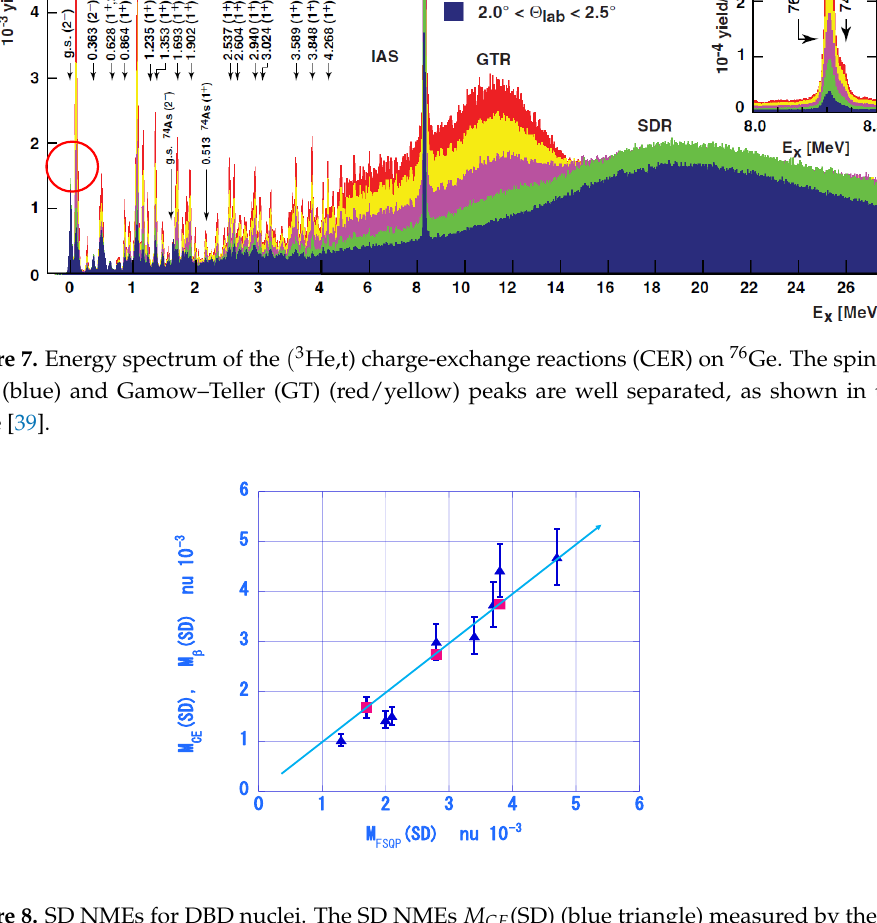
Figure 8. SD NMEs for DBD nuclei. The SD NMEs M CE (SD) (blue triangle) measured by the ( 3 He,t) CERs and the NMEs M β (SD) (red square) derived from the β decay ft values are plotted against the FSQP NMEs M FSQP